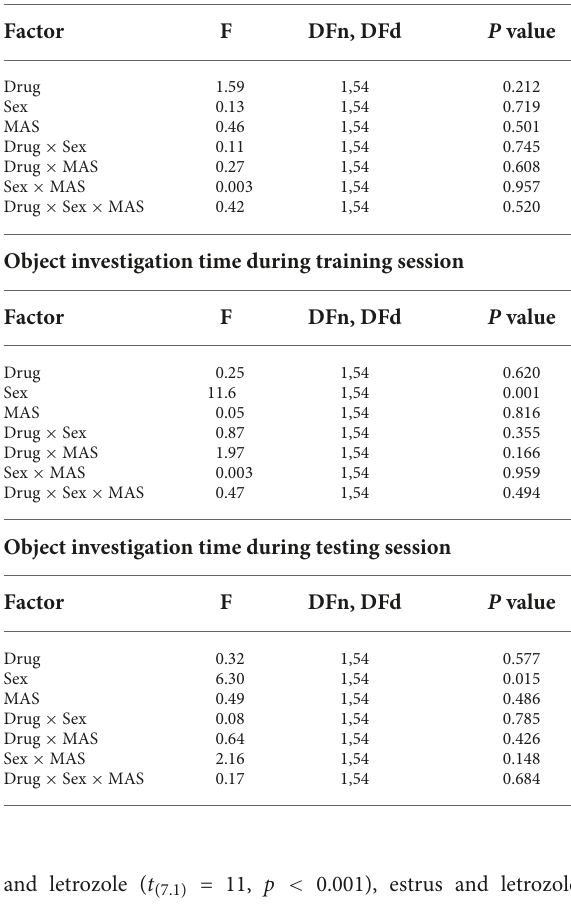
TABLE 1 Three-way ANOVA results of object bias during training and objection investigation times during training and testing. Object bias during training